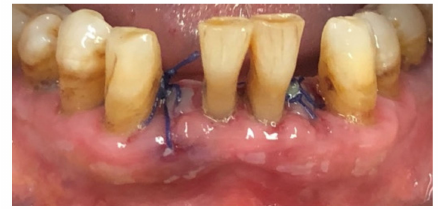
Figure 6. 3 day after surgery, Group B.